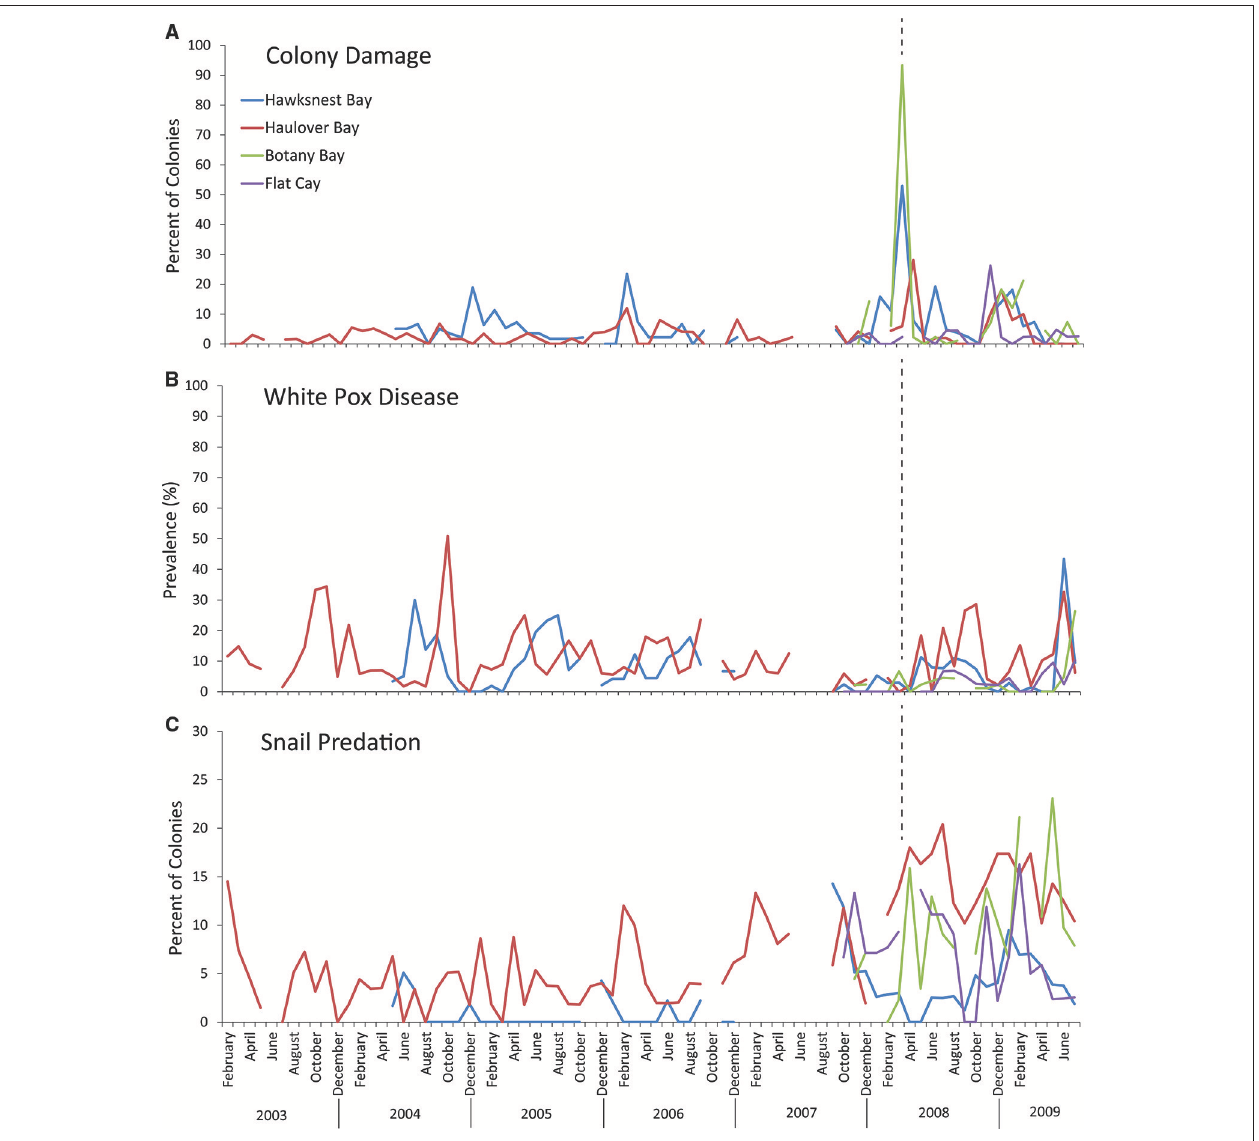
FIGURE 3 | Long-term trends in (A) colony damage, (B) white pox disease, and (C) snail presence on selected Acropora palmata colonies from the three northern sites, Botany Bay (max. monthly n = 91 colonies, mean monthly n = 62.2 ± 6.1; mean ± SE), Haulover (max monthly n = 99 , mean monthly n = 56.5 ± 1.6), Hawksnest (max. monthly n = 83 , mean monthly n = 53.3 ± 2.2), and a reference site at Flat Cay (max. monthly n = 45 , mean monthly n = 41.4 ± 0.9) on the south side of St. Thomas. Dotted lines represent the timing of the March 2008 swell